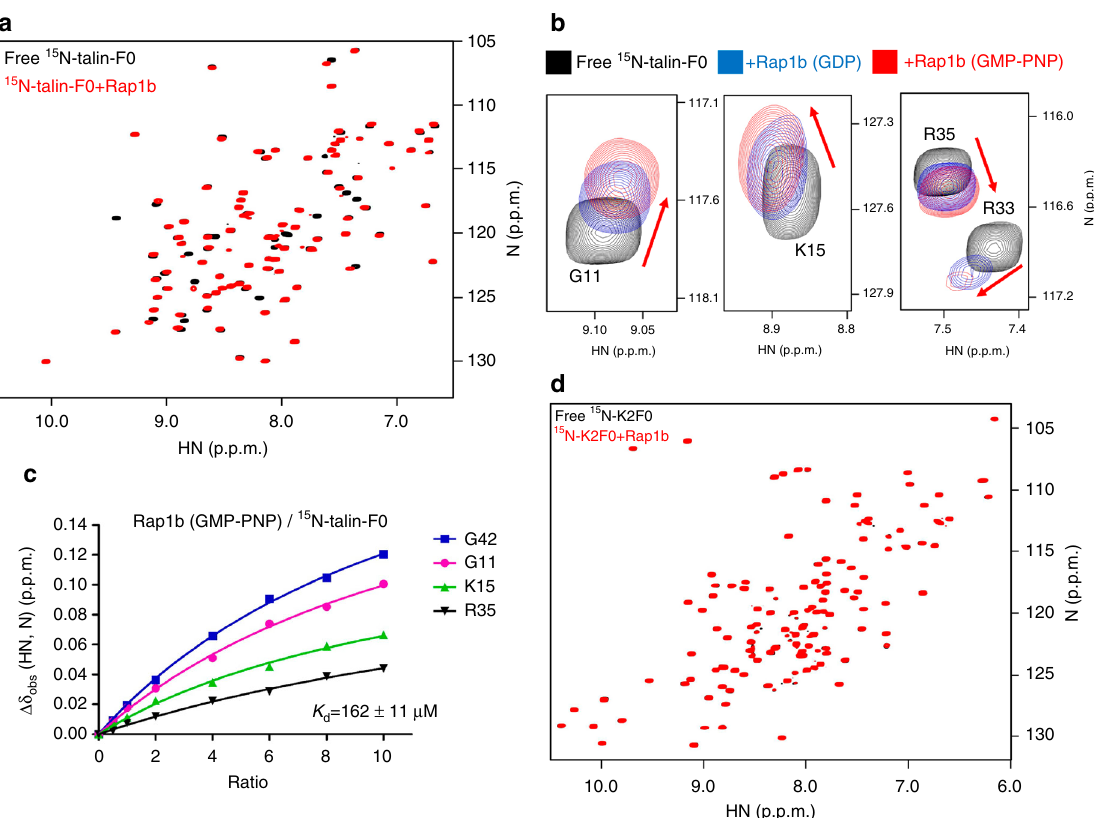
Fig. 2 Rap1b/talin-F0 interaction is GTP-dependent and speci fi c but is of weak af fi nity. a The HSQC spectra of 50 μ M 15 N-labeled talin-F0 in the absence (black) and presence of 125 μ M GMP-PNP loaded Rap1b (red). b The HSQC spectra (four representative residues were shown) of 50 μ M 15 N-labeled talin- F0 in the absence (black) and presence of 125 μ M GDP loaded Rap1b (blue) or GMP-PNP loaded Rap1b (red). Note that Rap1b-GDP induced the same overall pattern of chemical shift changes of 15 N-labeled talin-F0 as Rap1b-GMP-PNP does but with less peak shifts and broadenings, indicating a weaker af fi nity. c The af fi nity of Rap1b (GMP-PNP)/talin-F0 interaction measured by HSQC titration. d The HSQC spectra of 50 μ M 15 N-labeled kindlin2-F0 in the absence (black) and presence of 125 μ M GMP-PNP loaded Rap1b